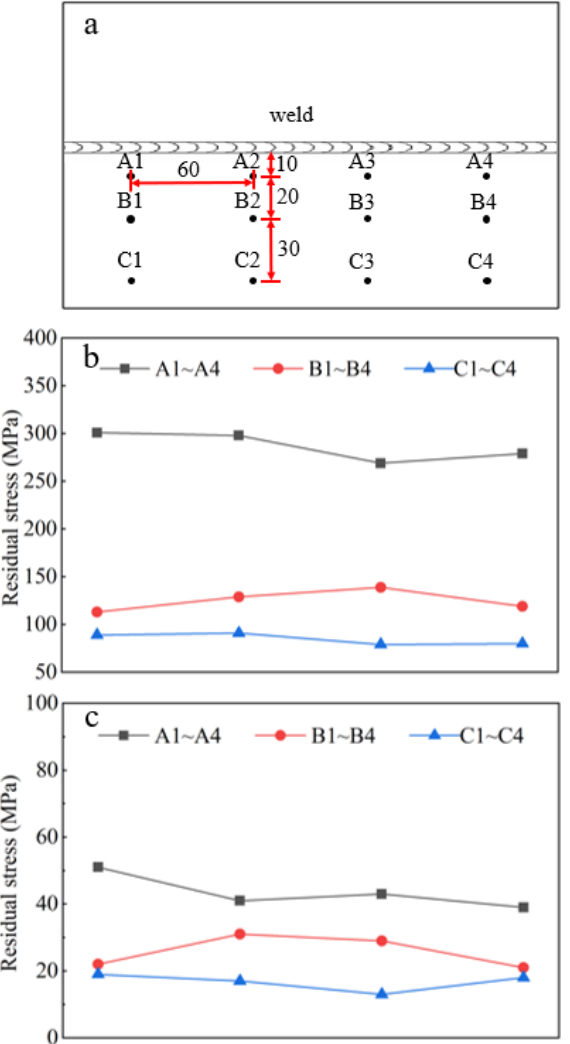
Figure 6. Diagram of residual stress. ( a ) Strain gauge distribution, ( b ) in welded state, and ( c ) after quenching and tempering.